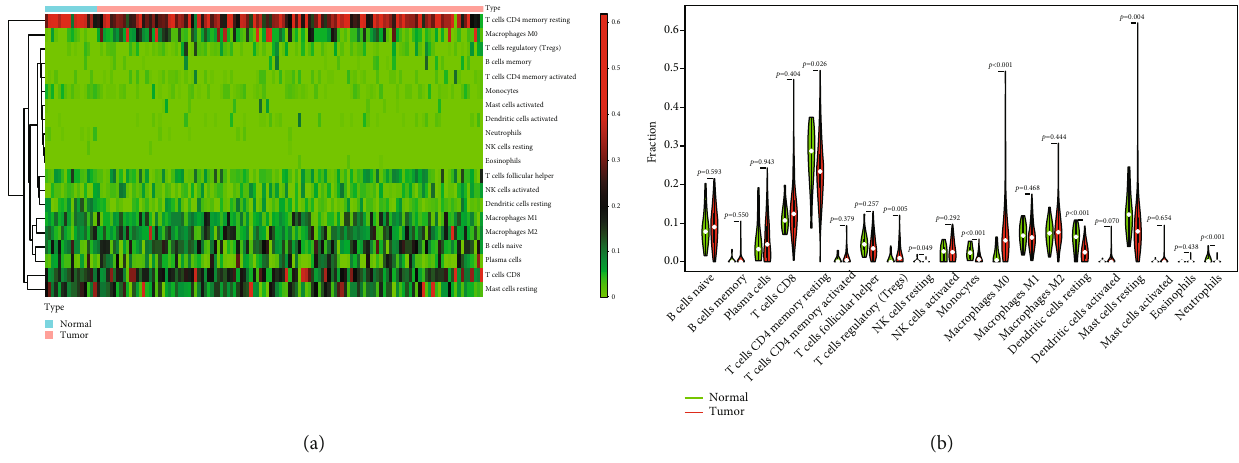
Figure 9: (a, b) Comparison of every kind of immunocyte between PCa and nontumor samples.